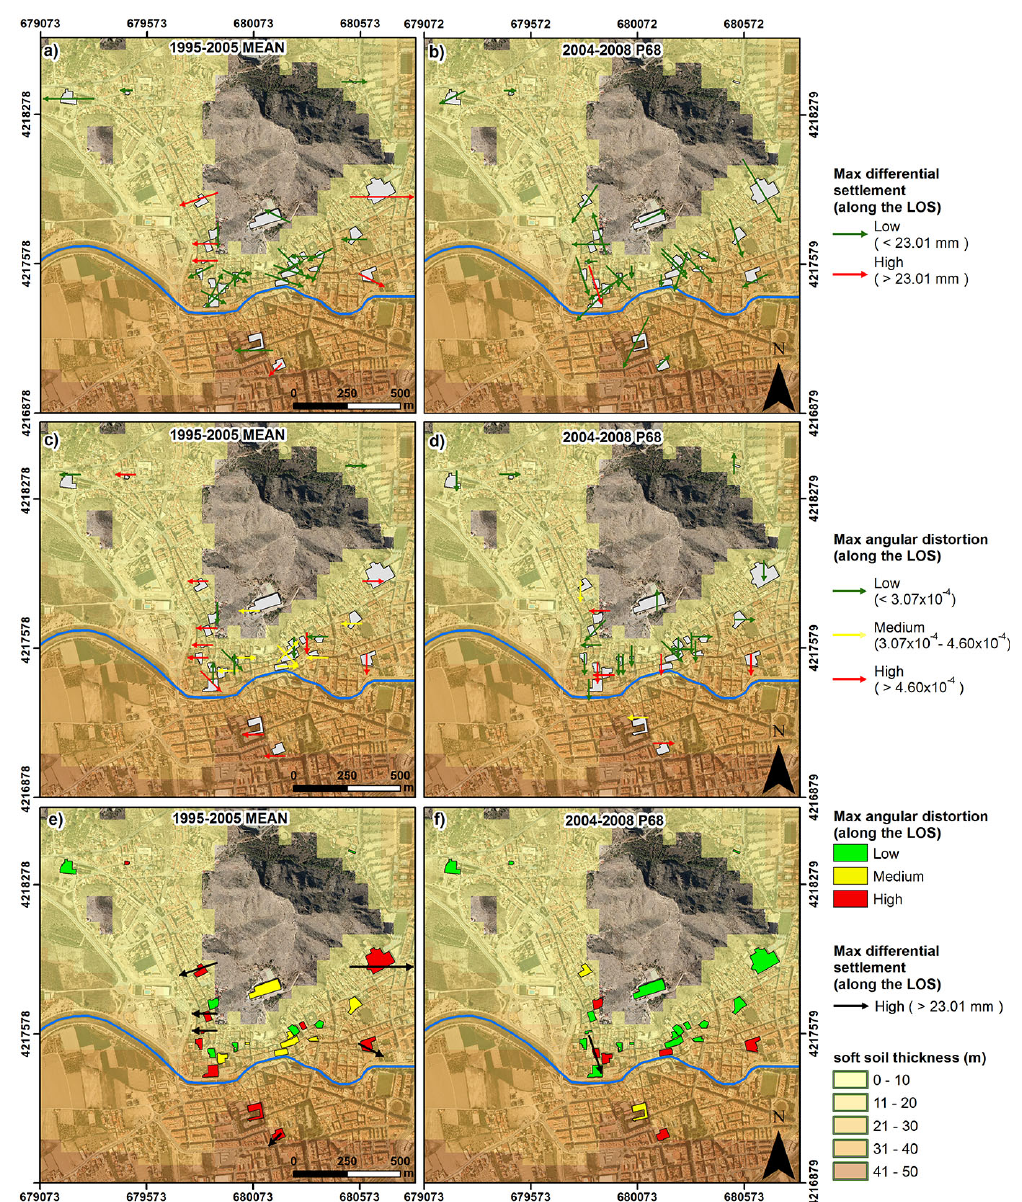
Figure 9. Local subsidence activity maps for both periods studied. Notice that the interpolation surfaces used are the mean and the 68th percentile for 1995–2005 and the 2004–2008 periods,